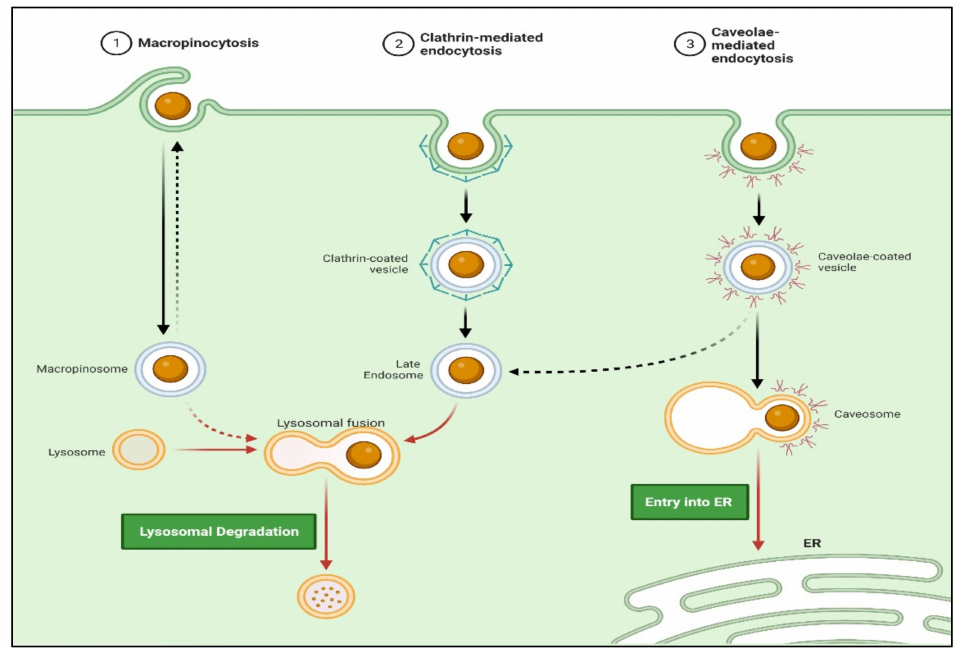
Figure 6. Active and passive uptake of nanoparticles to the HIV-infected tissues/organs. The active targeting strategy can include nanoparticle functionalization directly or indirectly with various molecules; such as drugs, nucleic acids (DNA or RNA), proteins or peptides, antibodies, etc., for ideal biological activities and diverse medical applications. (Created with BioRender.com (access on 19 June